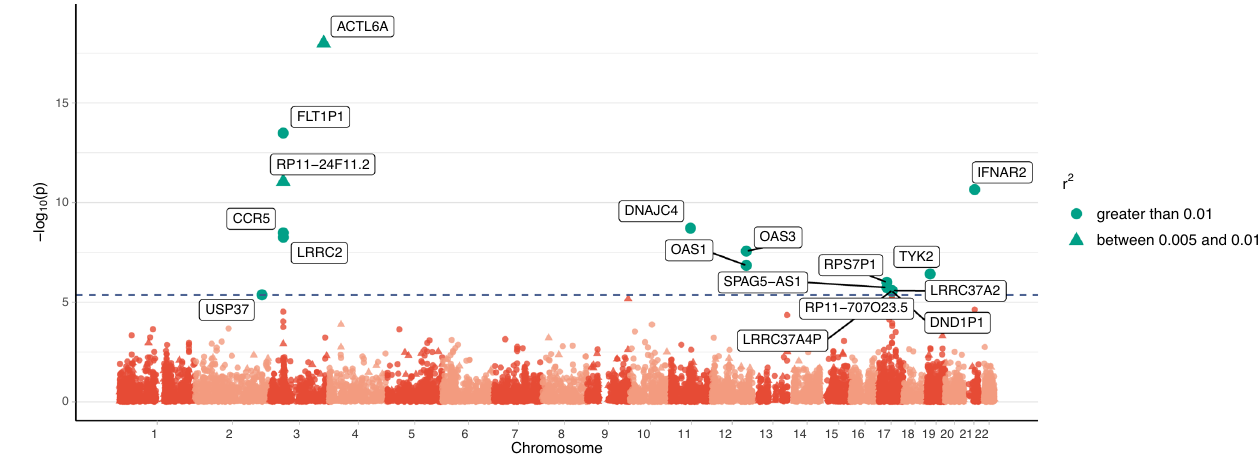
Fig.4|ManhattanplotforCOVID-19severity(B2outcome)comparinghospitalizedCOVID-19patientsandcontrols. p -valueswerecalculated bytheSUMMIT(two- sided). The horizontal line marks the genome-wide signi fi cance threshold (0.05/11539 ≈ 4.33×10 − 6